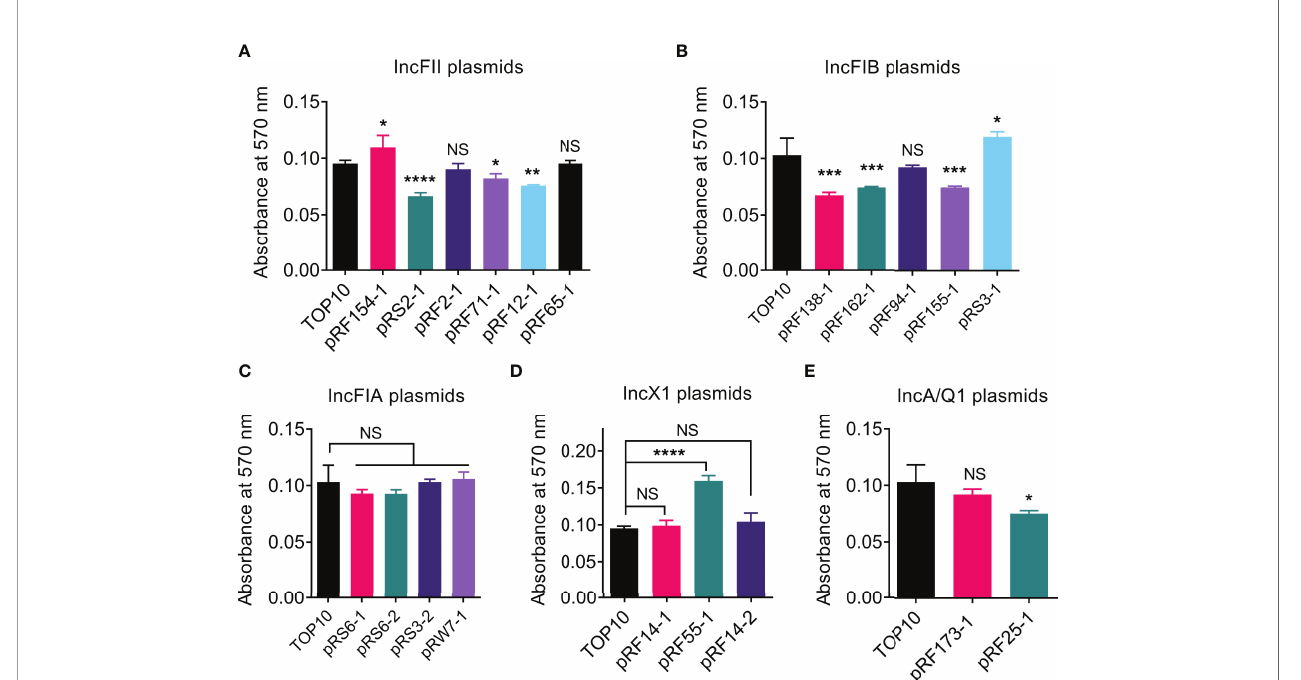
FIGURE 3 | The effect of tet (X4)-positive plasmids on bio fi lm formation. Comparison of bio fi lm formation between TOP10 and transformants carrying IncFII (A) , IncFIB (B) , IncFIA (C) , IncX1 (D) , or IncA/Q1 plasmids (E) . Bio fi lm formation ability was assessed using crystal violet method. Data are shown as mean ± SD from three biological replicates. Statistical analyses were conducted with unpaired, two-tailed t -test (* P ≤ 0.05, ** P ≤ 0.01, *** P ≤ 0.001, **** P ≤ 0.0001). NS, not signi fi